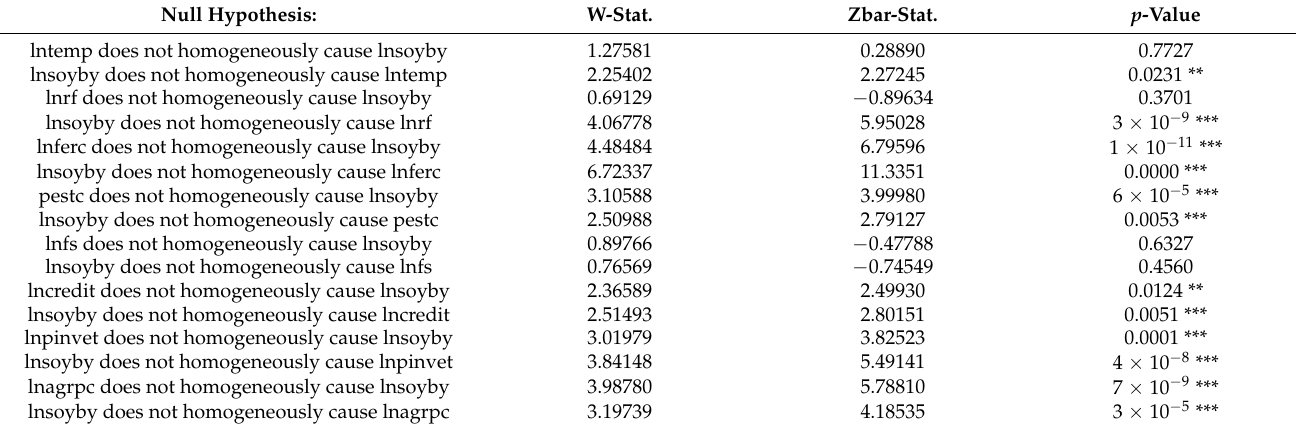
Table 7. D–H panel causality exploration.